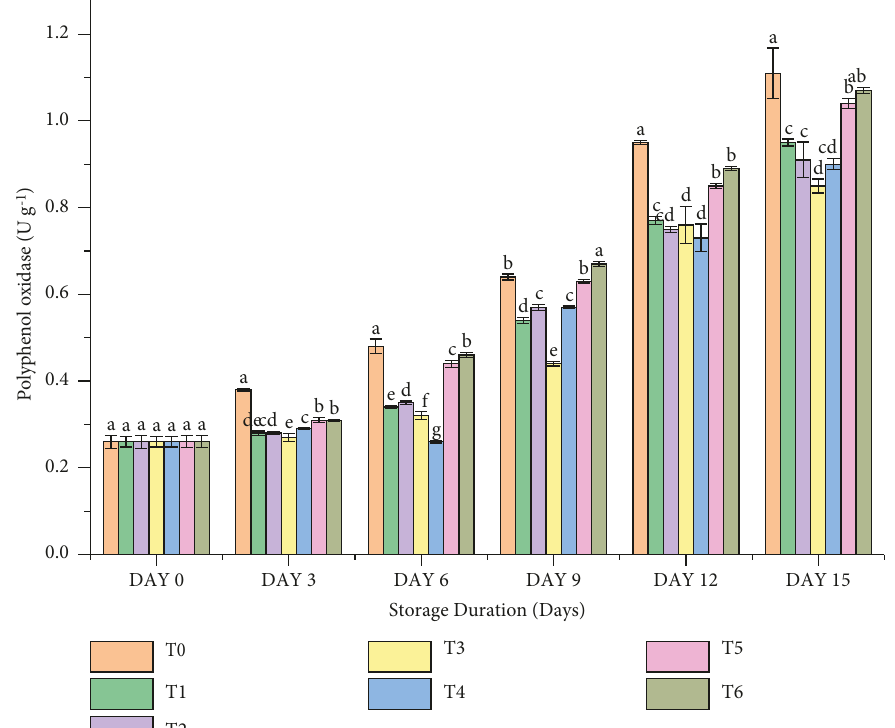
Figure 6: Effect of chitosan coating and cinnamon essential oil on polyphenol oxidase of pomegranate arils during storage at 4 ± 1 ° C. Vertical bars represent the mean ± SD of 3 replicates. Error bars with different letters on the same storage period show a significant difference ( P ≤ 0 . 05). T0 � control; T1 � 1% chitosan+0.25% oil; T2 � 1% chitosan+0.5% oil; T3 � 2% chitosan+0.25% oil; T4 � 2% chitosan+0.5% oil; T5 � 3% chitosan+ 0.25% oil; T6 � 3% chitosan+0.5%